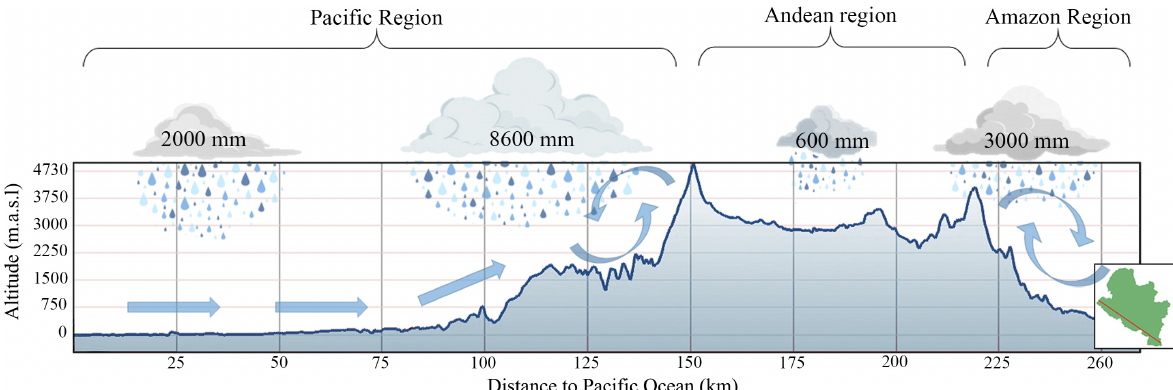
Figure 8. Cross-section profiles of Nariño showing the influence of the Tropical Pacific Ocean, Andes mountain, and Amazon